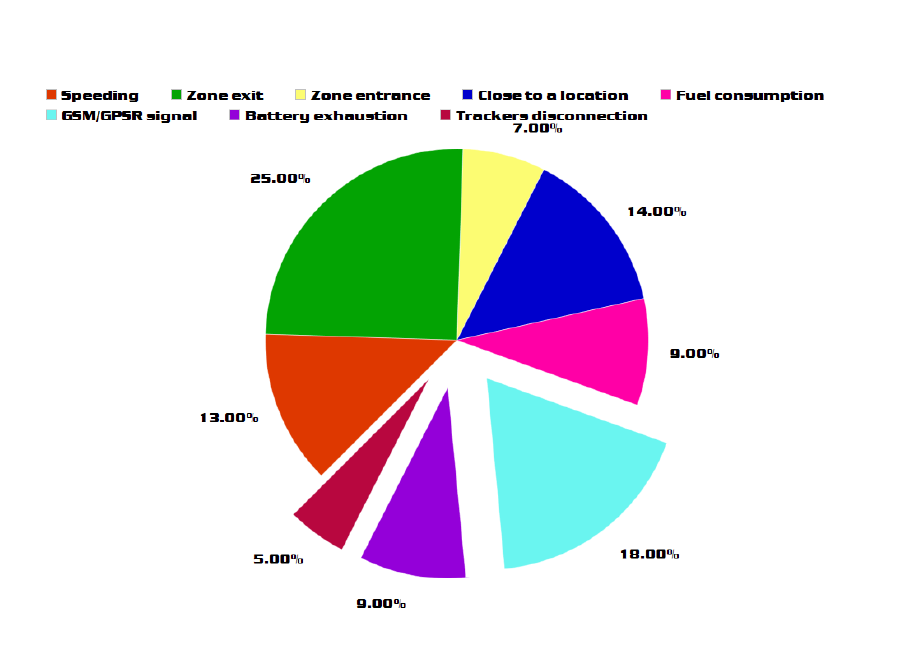
Figure 12. Chart representing the percentage value of the appearance of the different types of notifications.The most frequent is ’zone